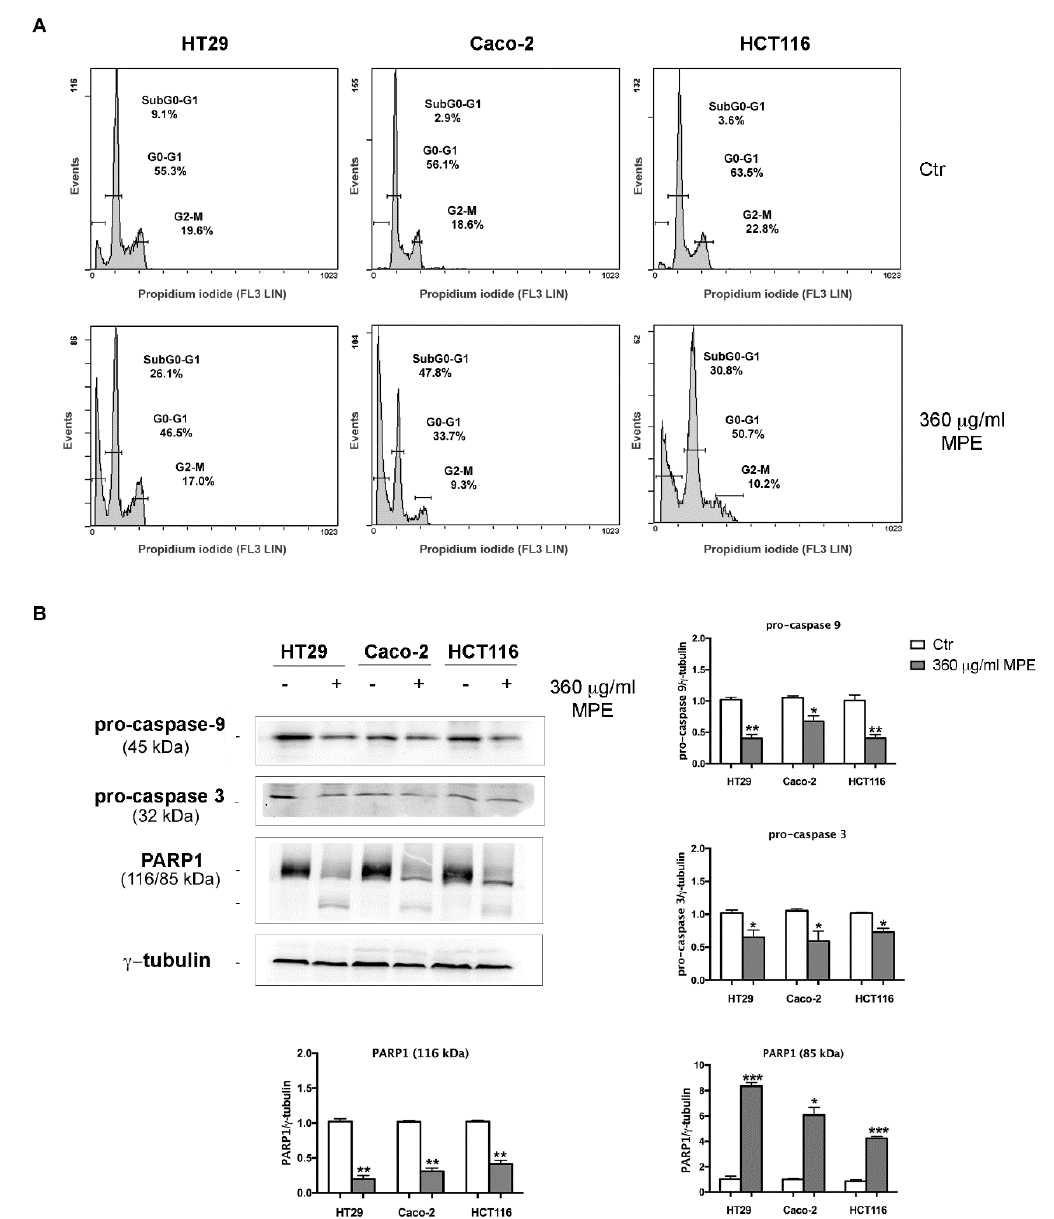
Figure 4. MPE effects on cell cycle phase distribution, caspases activation and PARP1 fragmentation. ( A ) Flow cytometry analysis of cell cycle phase distribution of HT29, Caco-2 and HCT116 cells exposed to MPE treatment for 48 h. ( B ) Western blotting analyses of pro-caspases-9 and -3 and PARP1 were performed